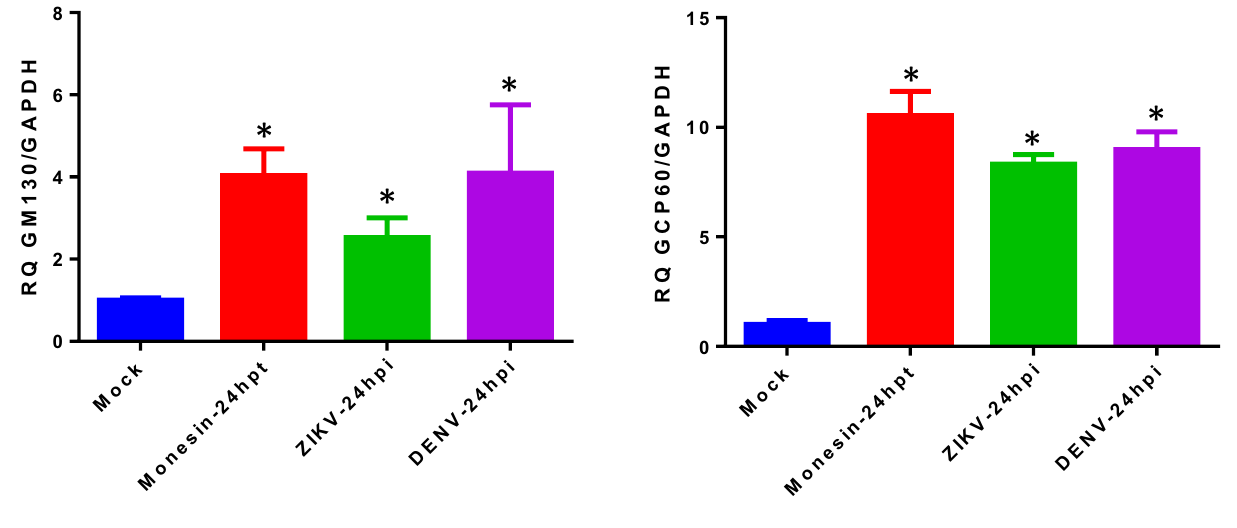
Figure 3. Increase expression of genes targeted by the TFR3 pathway in infected cells. BHK-21 cells were infected with DENV and ZIKV using a MOI = 3 and harvested at 24 hpi. Mock infected and monensin treated cells were included as negative and positive controls, respectively. Changes in GOLGA 2 (GM130) and GCP60 gene expression levels were quantified by qRT-PCR using the delta-delta Ct method and GAPDH as housekeeping gene. Results are the mean ± SD of two independent experiments. Differences in mRNA expression levels were analyzed for statistical significance using the ANOVA test. *p ≤ 0.05.